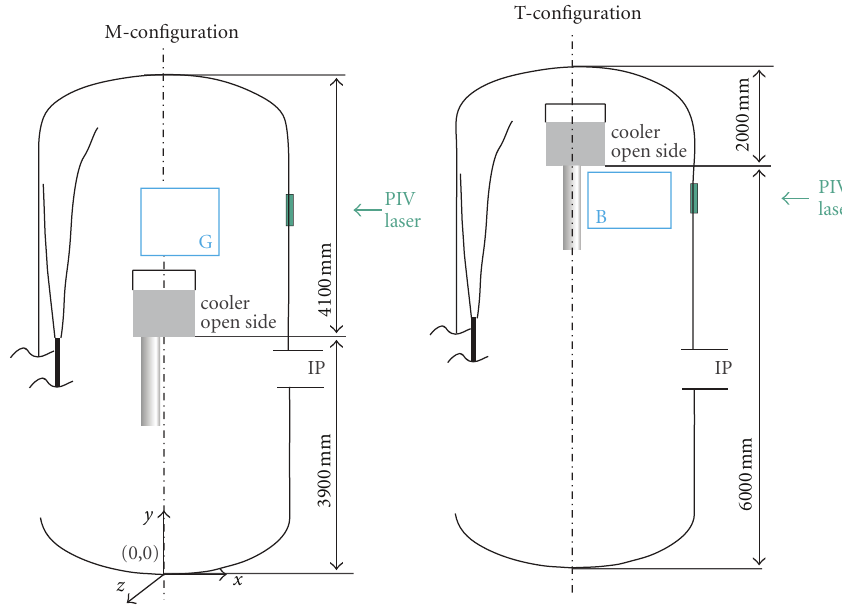
Figure 5: Schematic representation of field of view locations used.